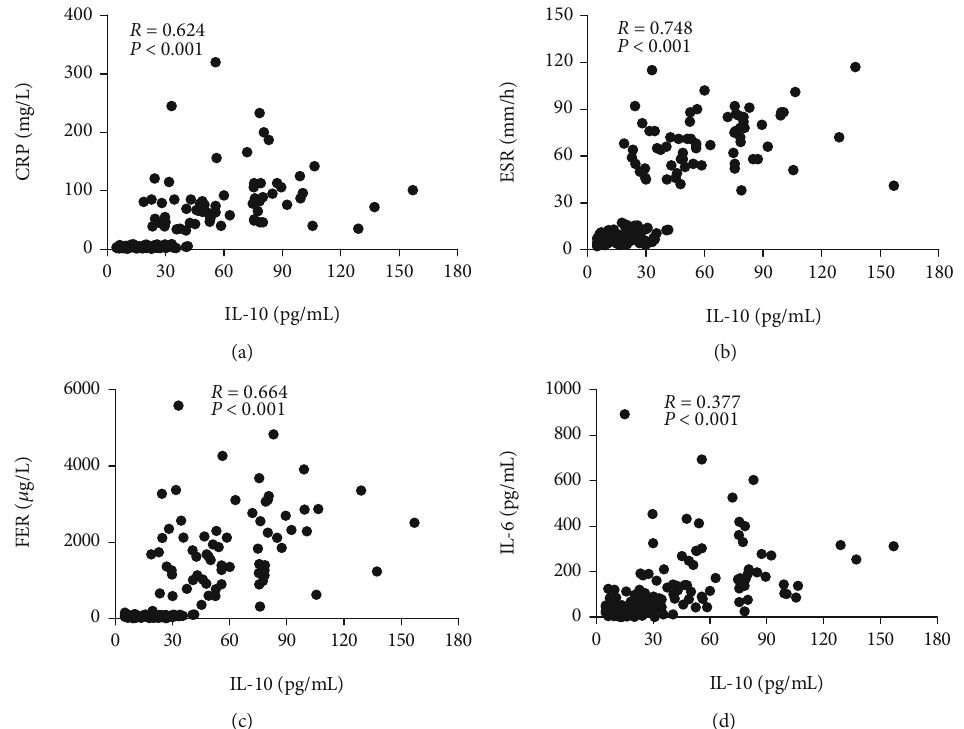
Figure 3: Correlation between serum IL-10 and other biomarkers. Serum IL-10 levels were positively correlated with CRP (a), ESR (b), FER (c), and IL-6 (d). Table 2: Characteristics of SoJIA patients with monocyclic pattern or nonmonocyclic pattern.